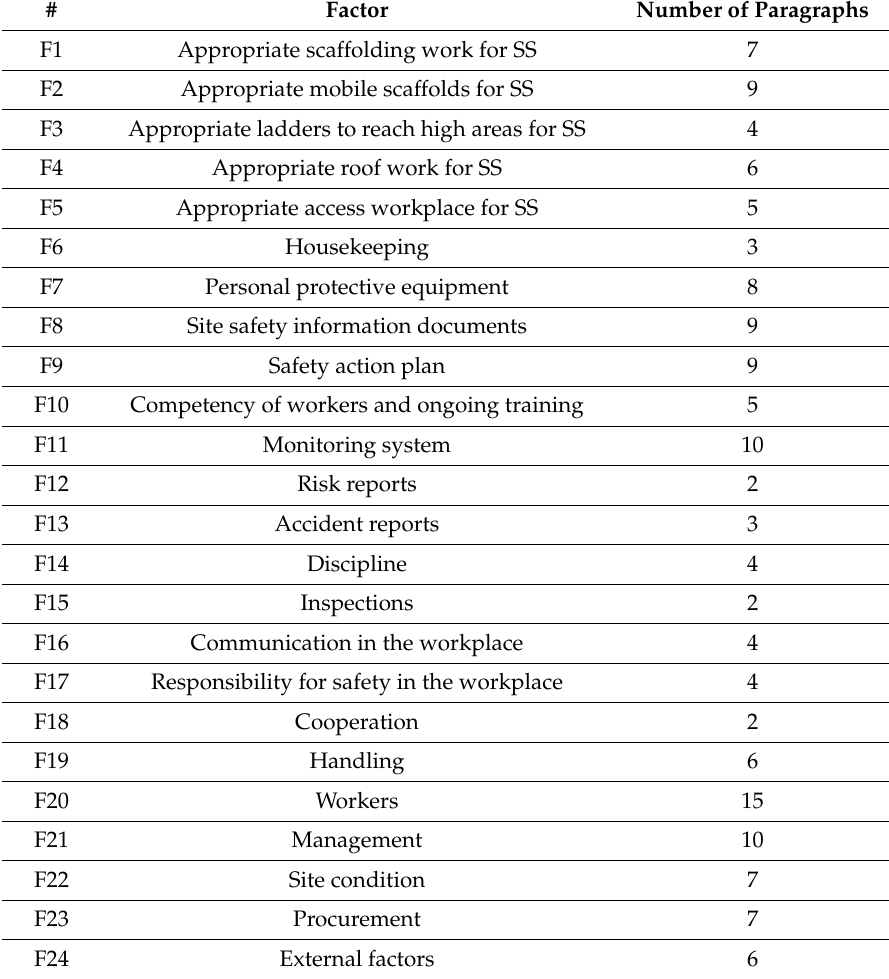
Table 2. Safety factors during IPh identified as having potential positive effects on minimising CW.